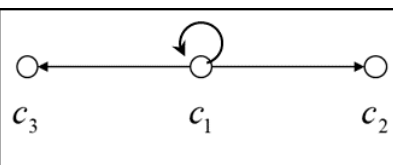
Figure 4. One-dimensional three-velocity (D1Q3) model ( C 1 , C 2 and C 3 represent three adjacent points on the axis).